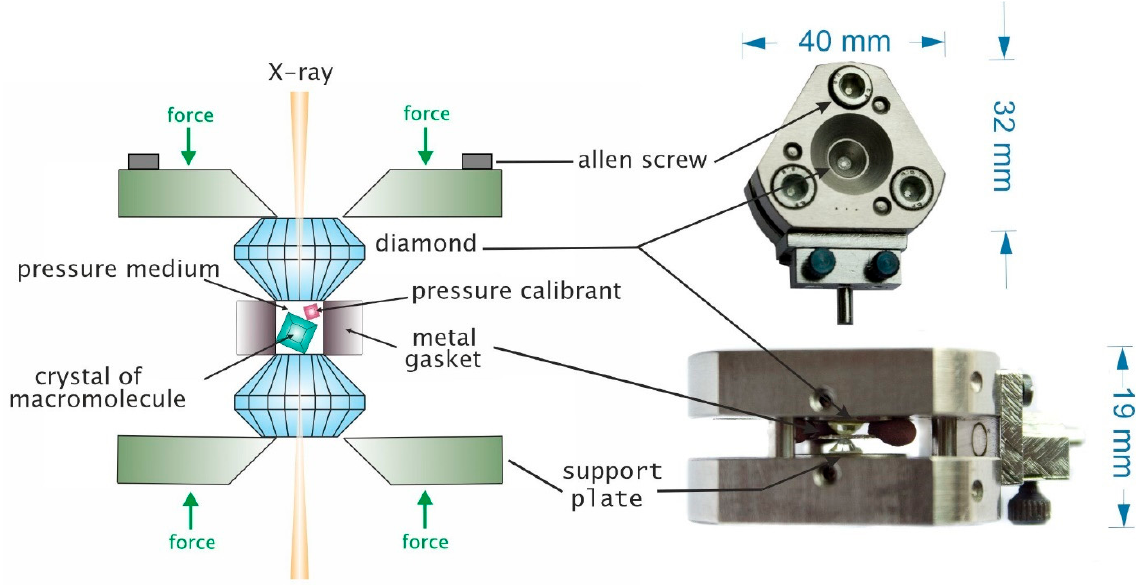
Figure 3. Diamond anvil cell: scheme of the core body of the 60-degree diamond anvil cell (on the left ), a photograph of the core body of the cell once assembled, before it is put in position on the goniometer (on the right ). The drawing is scaled for clarity.